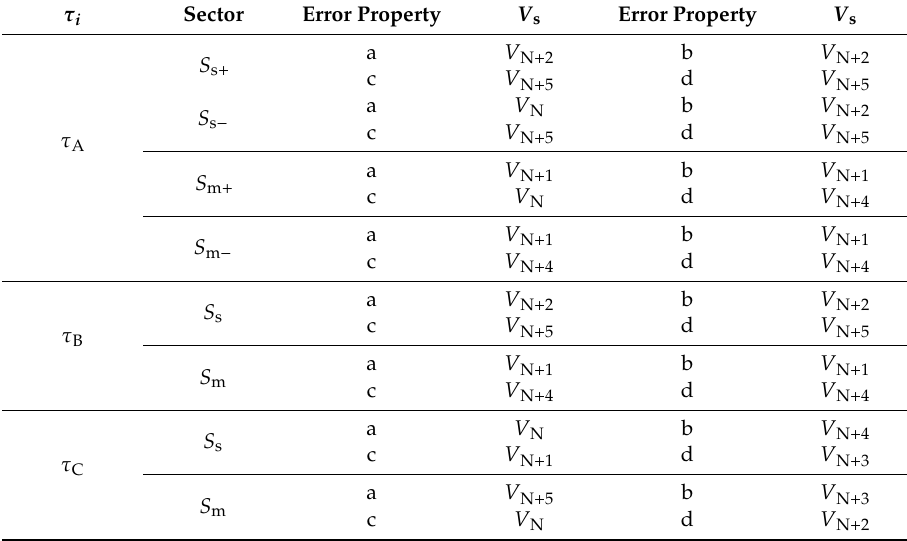
Figure 12. Fixed sector division results.